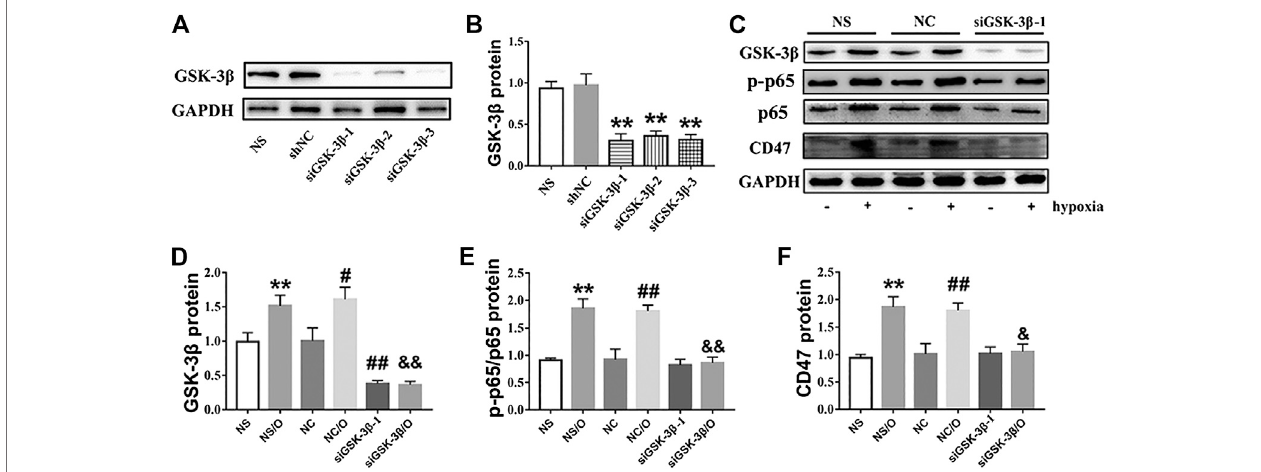
FIGURE 7 | siGSK-3 β reduces the expression of CD47 in hypoxia-induced H9c2 cells. (A, B) . siGSK-3 β -interference ef fi ciency was examined using western blot. ** p < 0.01 vs. siNC. (C) H9c2 cell lysates of siGSK-3 β , siNC, and vehicle control groups after hypoxia induction were analyzed using western blot. (D – F) Bar graphs showing fold-changes. “ O ” stands for hypoxia treatment. ** p < 0.01 vs. NS; # p < 0.05, ## p < 0.01 vs. NC; & p < 0.05, && p < 0.01 vs.